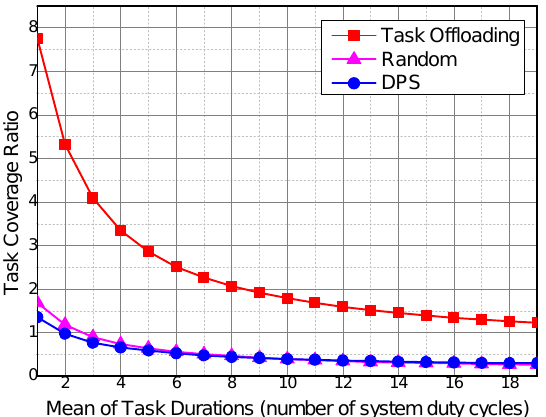
Figure 10. Impact of task durations on task coverage ratio.